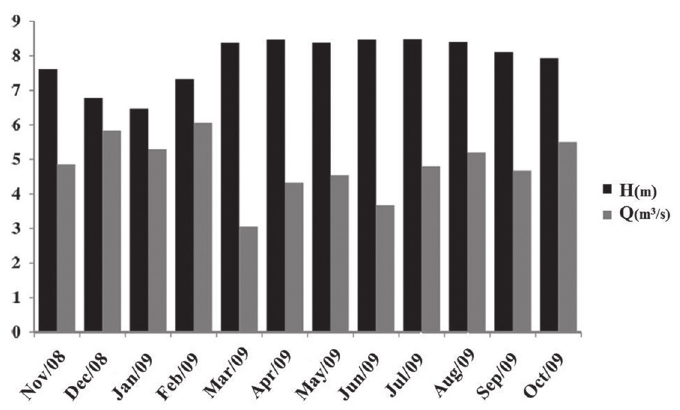
Figure 5 - Height of the water level in the lake (H) and flow of pumping of water from the Guamá river